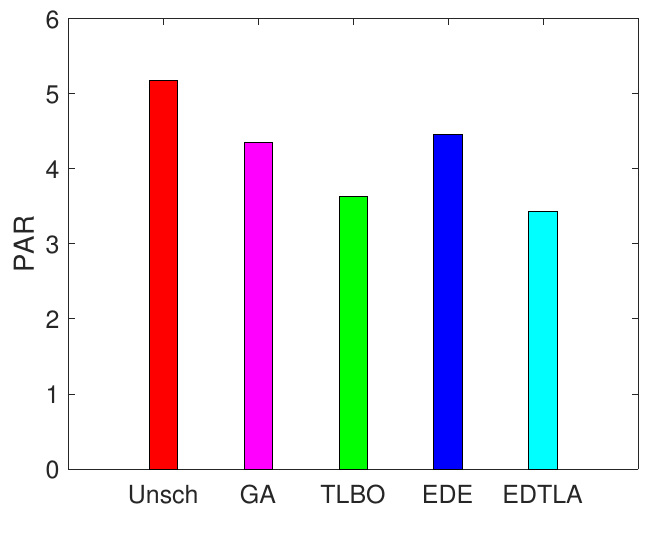
Figure 18. Peak to average ratio